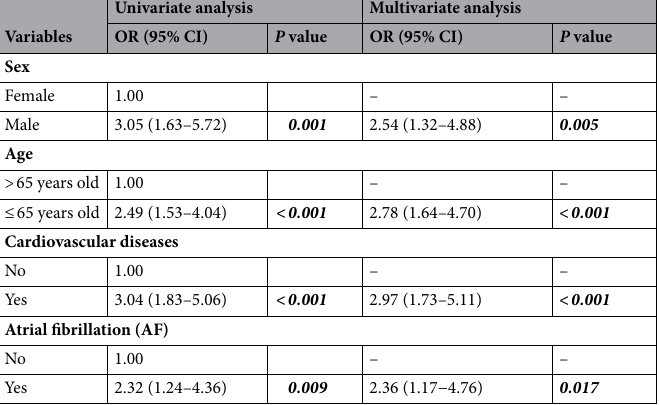
Table 3. Multivariate logistic regression: independent predictors for VT/VF in witnessed OHCA patients. Statistically significant ( P < 0.05) are given in bold italic. Variables entered on step 1: sex, age, cardiovascular disease, ECG parameters of ventricular rate, sinus rhythm, atrial fibrillation, QRS duration, and frontal QRS-T angle. OHCA, Out-of-hospital cardiac arrest; VT, ventricular tachycardia; VF, ventricular fibrillation.